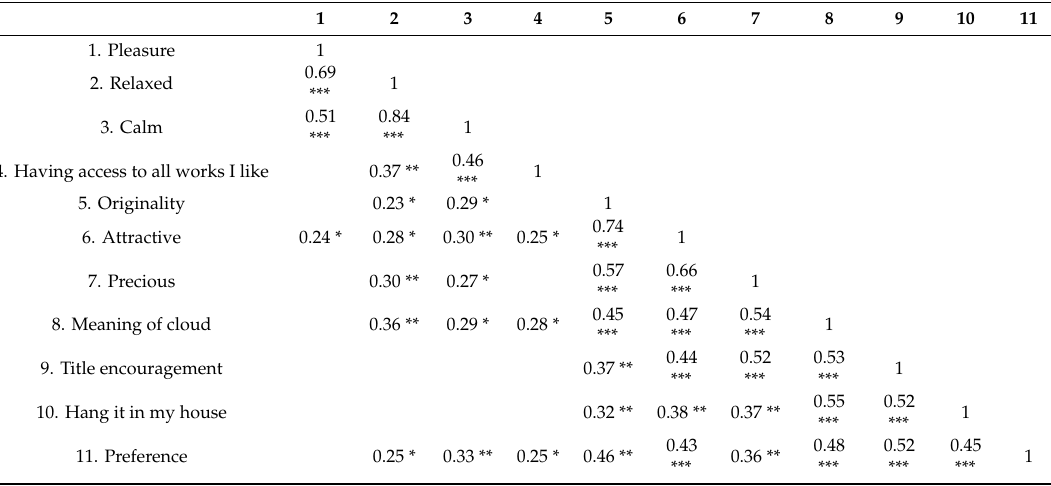
Table 2. Pearson correlation coe ffi cients for the significant